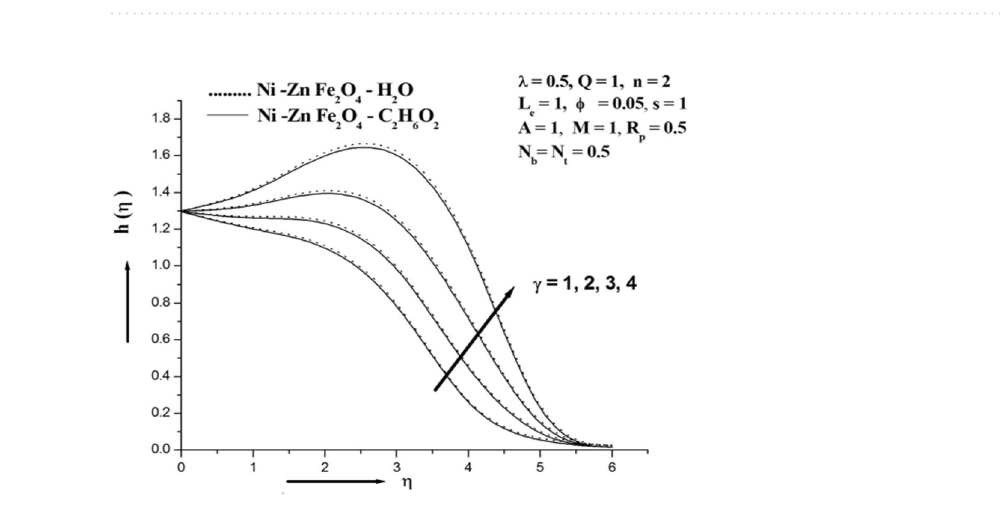
Figure 4. Illustration of concentration for various R p .